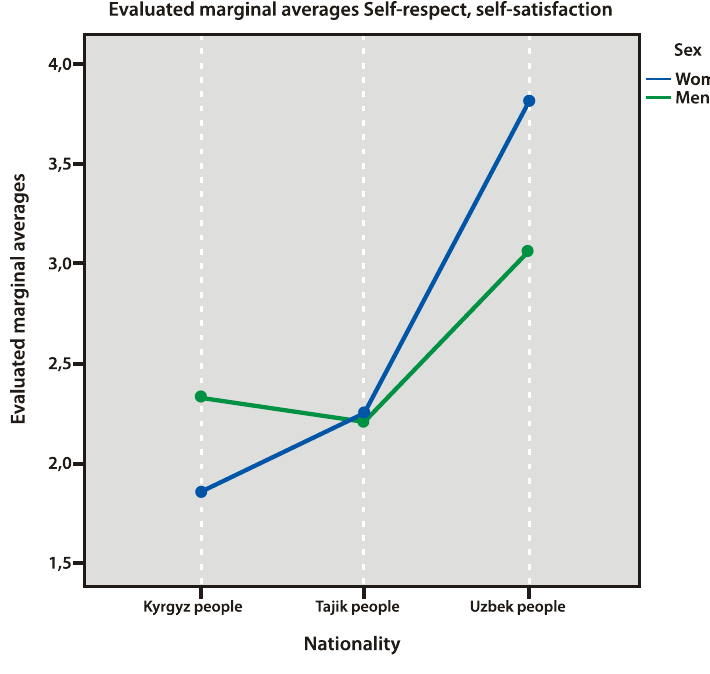
Figure 9. Self-satisfaction factors.